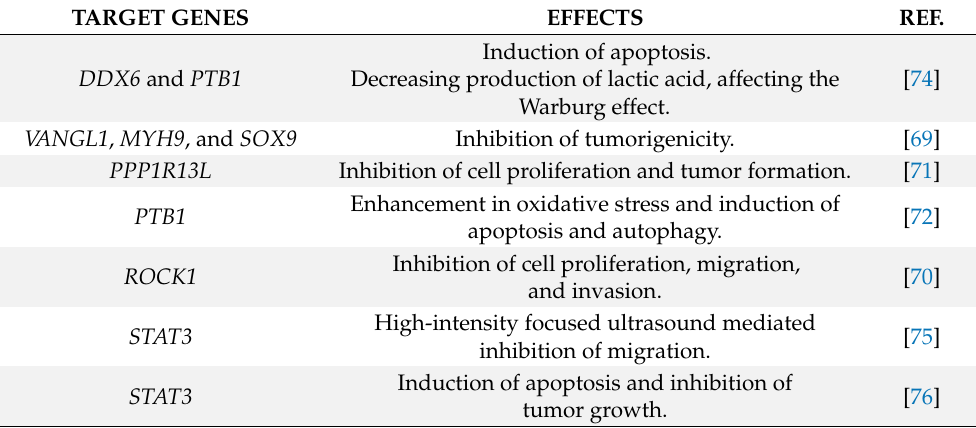
Table 3. Anti-tumor function of miR-124 in colorectal cancer.